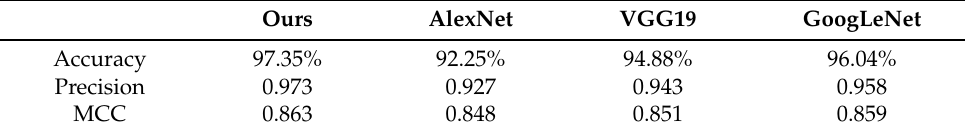
Table 4. Comparison of CNN models and our proposed model.